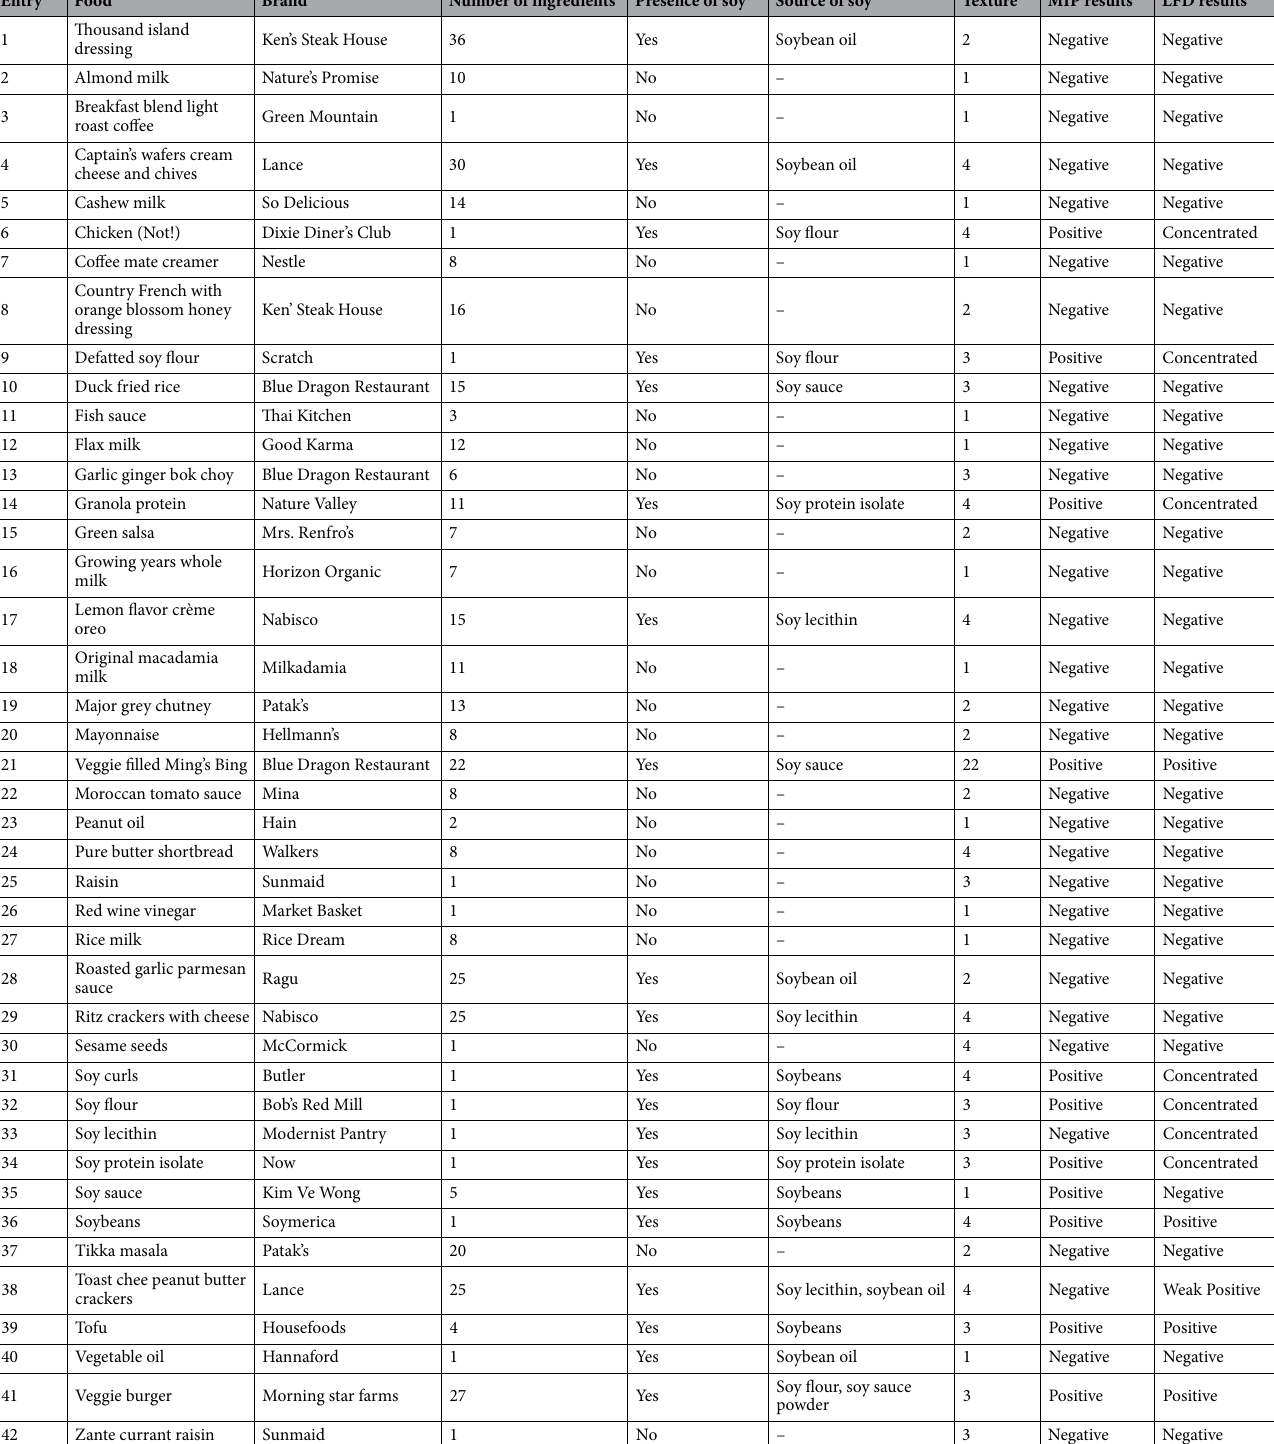
Table 1. Detection responses recorded for MIP-coated electrodes and LFDs during food product measurements. A positive test result for both MIP and LFD kit detection confirms that soy allergen is present within a tested sample. a As reported in ingredients lists. b Based on scale 1–4 with 1 liquid, 2 viscous liquid and emulsions, 3 gelatinous and soft solid, 4 hard solid. c Based on triplicated electrochemical